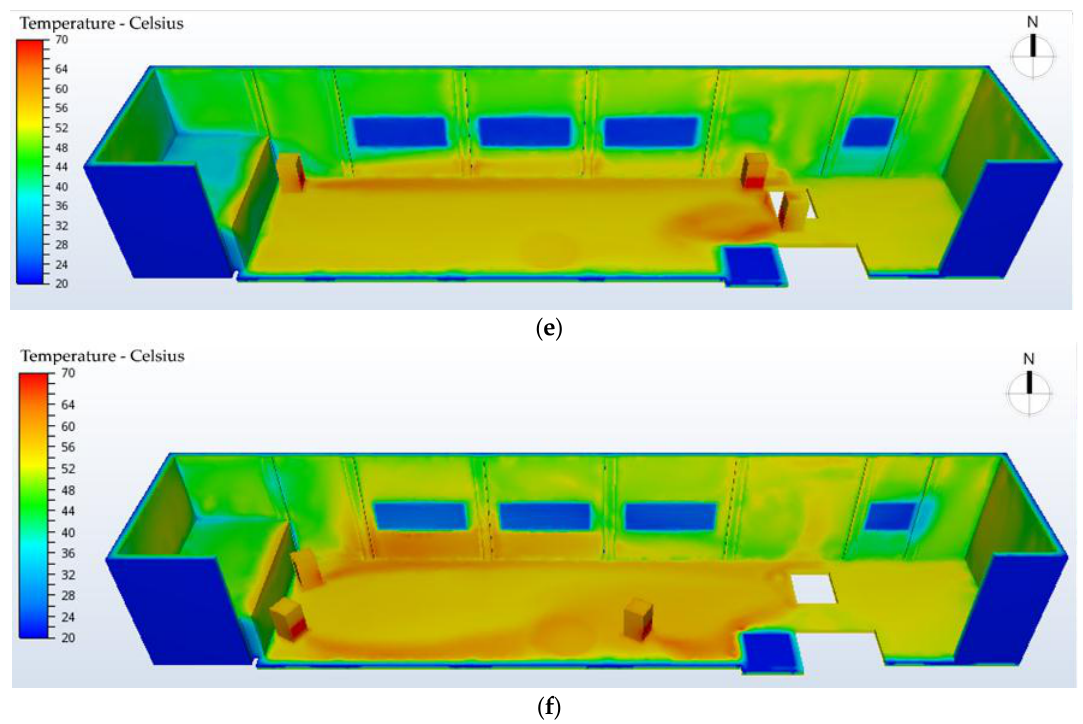
Figure 7. Perspective view (without showing machinery) of the north wall. ( a ) Initial configuration, ( b – f ) changes in the position/orientation of the fan heaters.